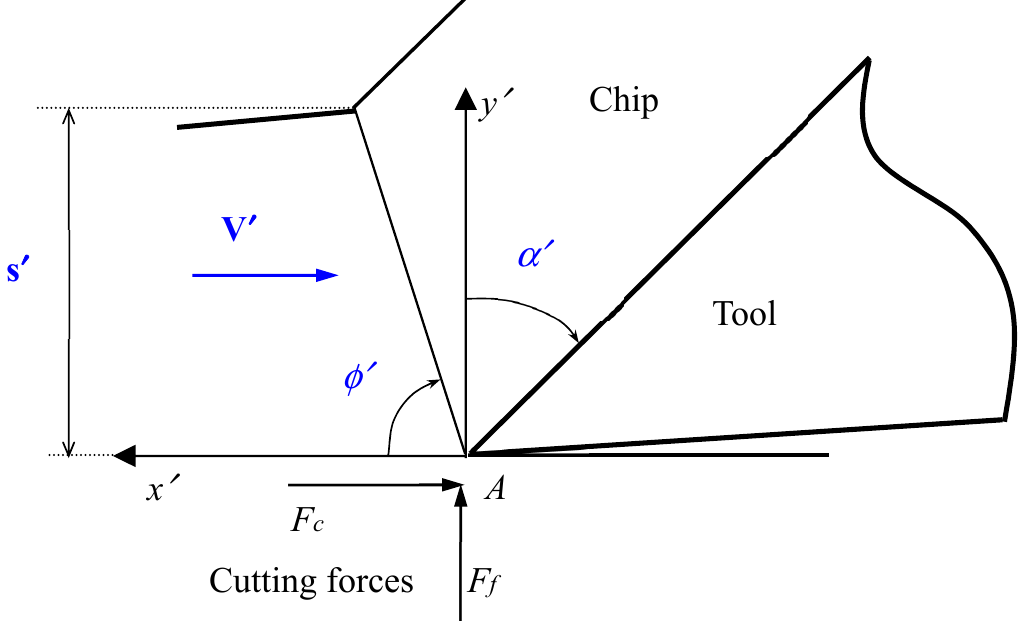
Figure 2. At each time t , an equivalent cutting steady-state operation is introduced. The associated instantaneous cutting conditions V (cid:48) , α (cid:48) , and s (cid:48) represent the cutting speed, the tool rake angle, and the uncut chip thickness, respectively.